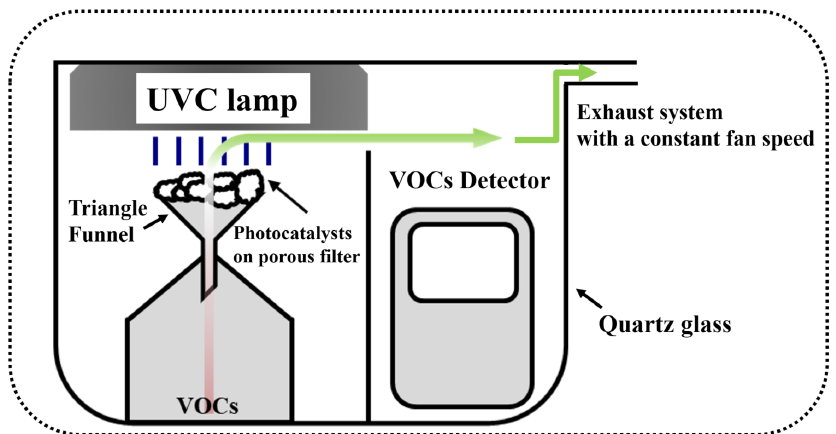
Figure 6. Schematic image of photocatalytic experimental setup.